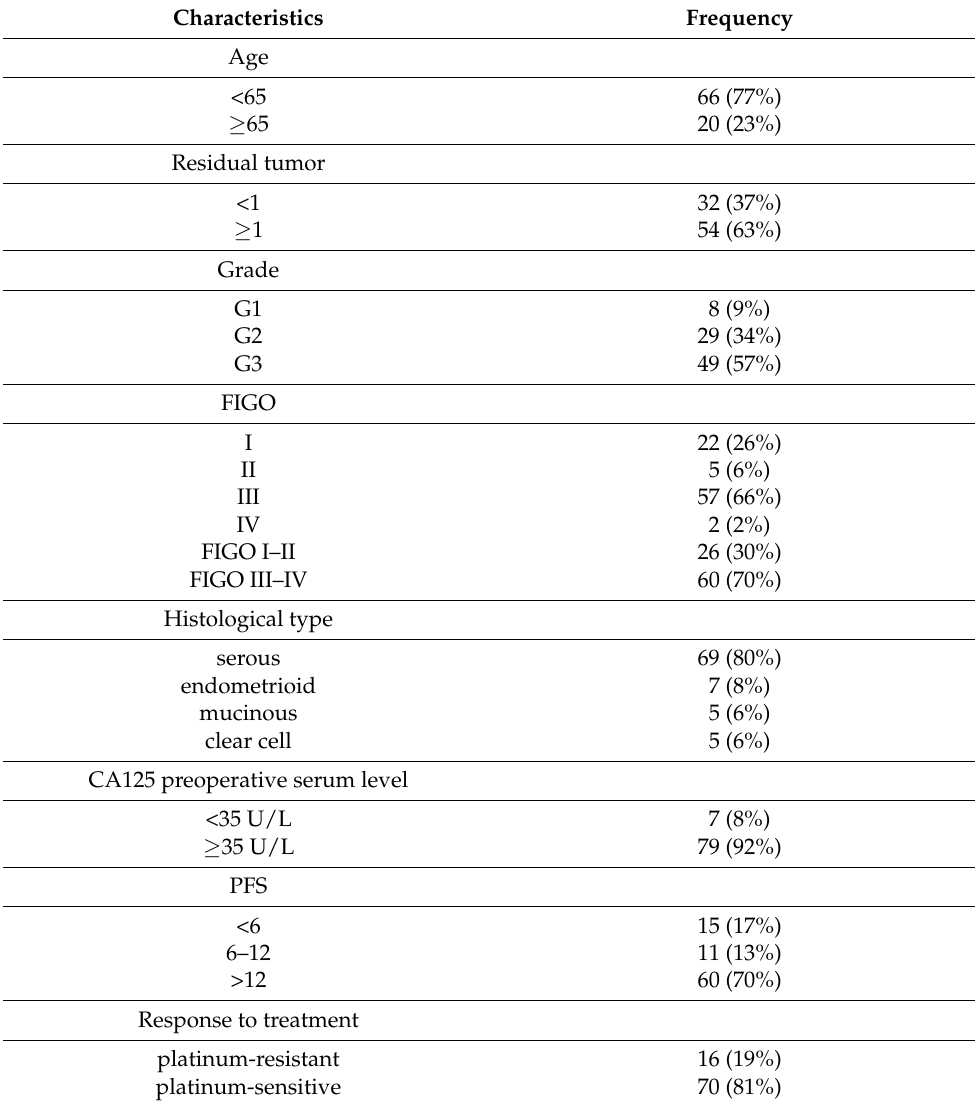
Table 1. Clinicopathological characteristics of